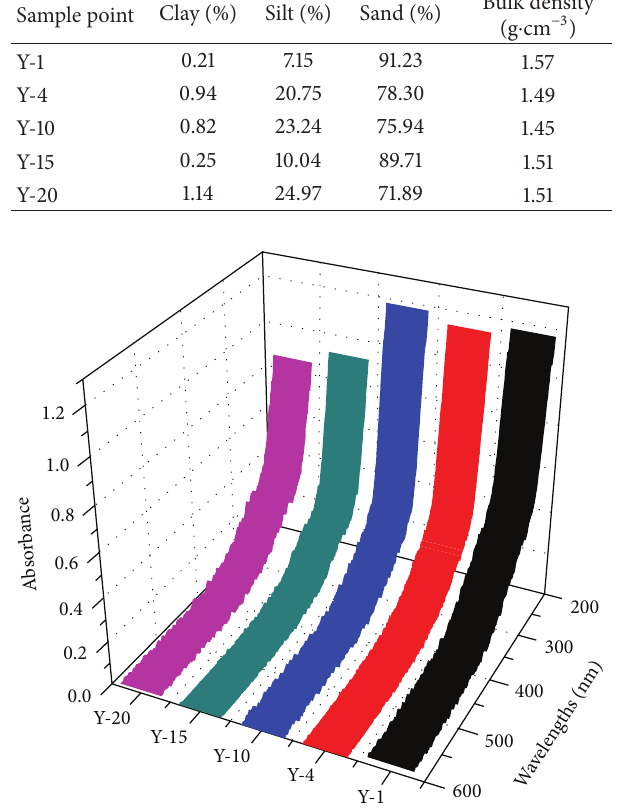
Figure 2: UV-Visible spectra of the soil